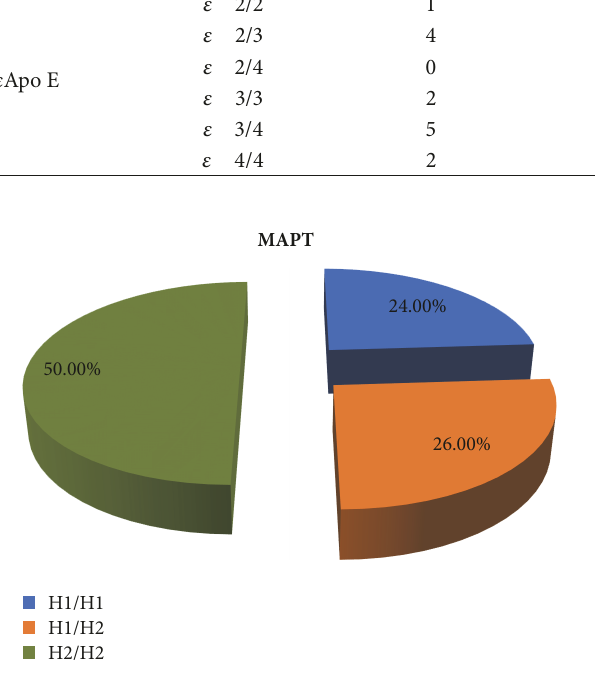
Figure 2: Percentage of different MAPT haplotypes in all patients.